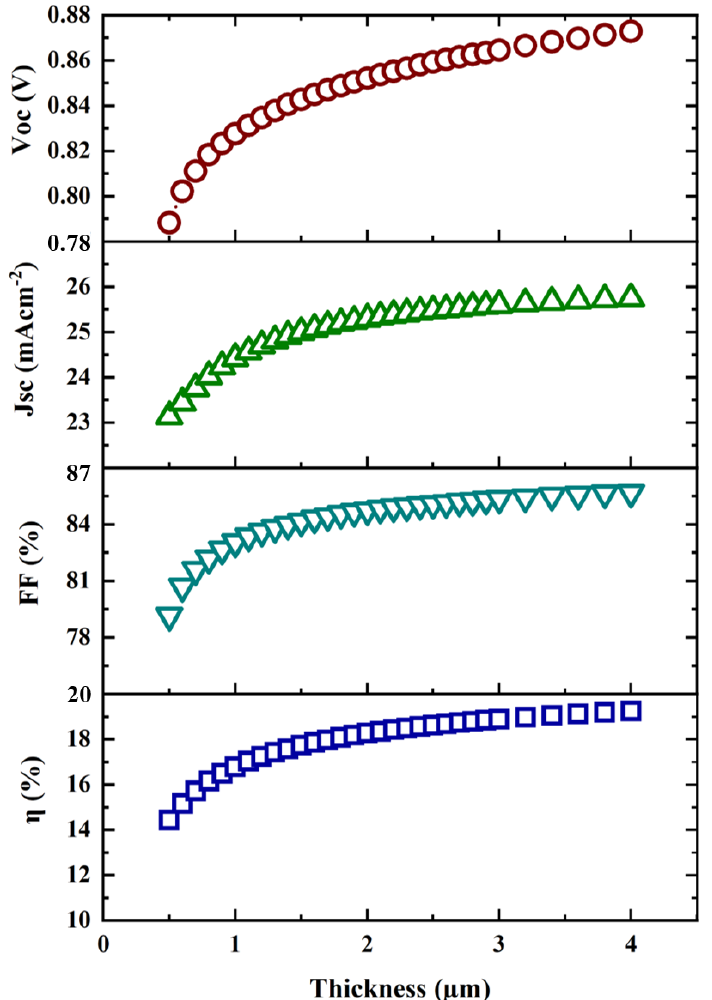
Figure 4. Absorber layer thickness versus V oc , J sc , FF, and η.